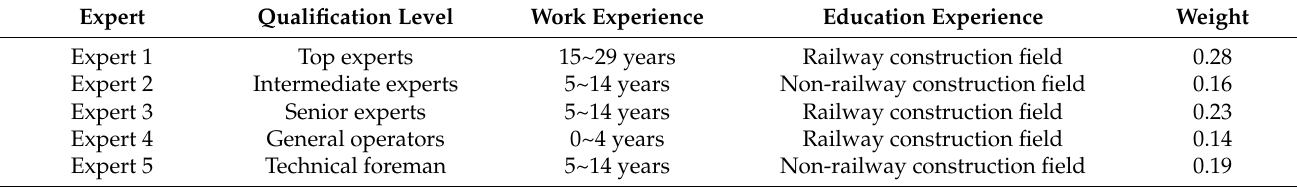
Table 7. Expert personal information and weight.